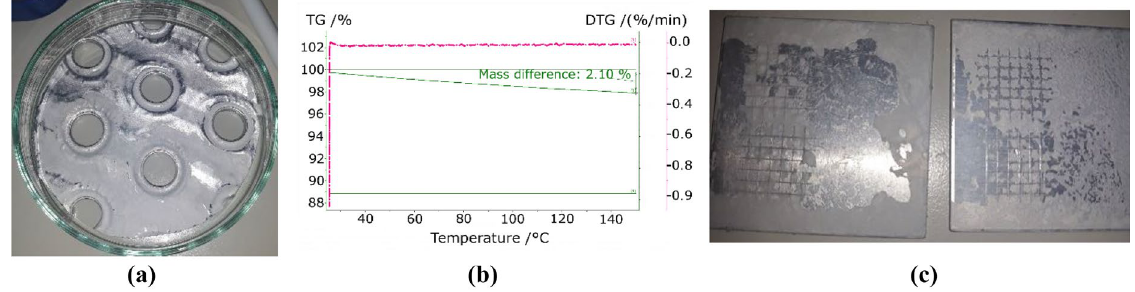
Figure 11. ZnSO 4 coating with HEC: ( a ) fin, ( b ) TGA, ( c ) cross-cut test without (left) and with HEC (right).